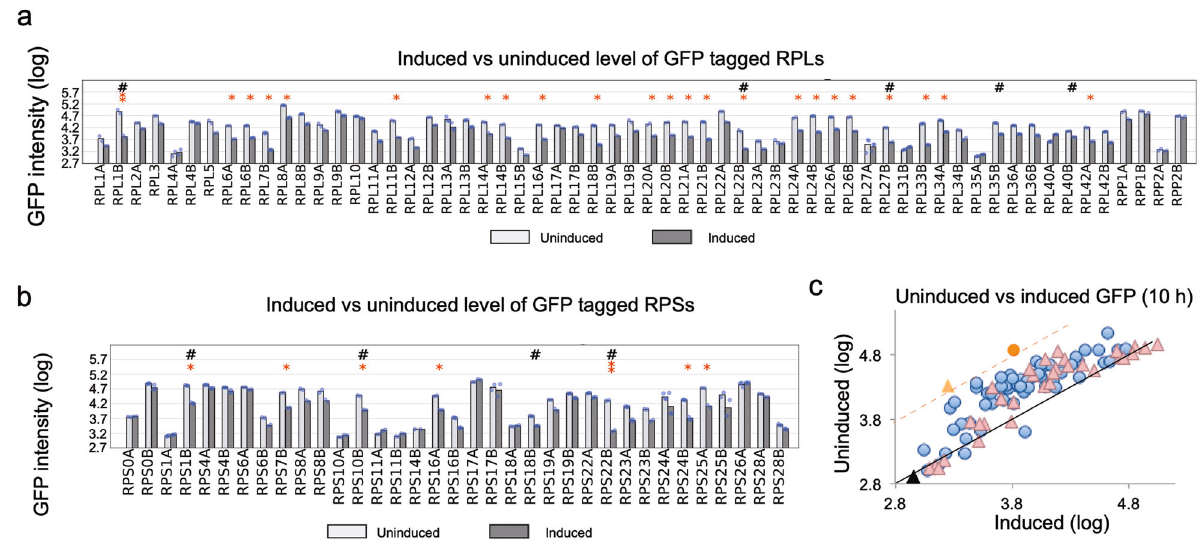
Fig. 2 Screening of ribosomal protein expression. a Sixty large ribosomal subunit proteins were screened for expression changes. Dots show the log10 expression level for each biological replicate, and the bars indicate the mean values, for both induced and uninduced conditions. Genes with more than a 10-fold reduction of their endogenous protein after induction of their cre-less protein are highlighted with two stars (**). Genes with a 3-fold to 10-fold reduction are highlighted by one star (*). Genes with one paralog effected by >2-fold more than the other paralog are highlighted with #. b Thirty- fi ve small ribosomal subunit proteins were screened for expression changes. c Scatterplot showing the uninduced vs. induced log10 GFP levels for large ribosomal subunit proteins (triangles) and small ribosomal subunit proteins (circles). RPL1B (red circle) and RPS22B (orange triangle) showed the highest levels of autoregulation. The black line passing through the center represents equal GFP levels for induced and uninduced, while the orange dotted line represents a 10-fold reduction in the induced compared to uninduced. The black triangle is BAC177 with no GFP-tagged